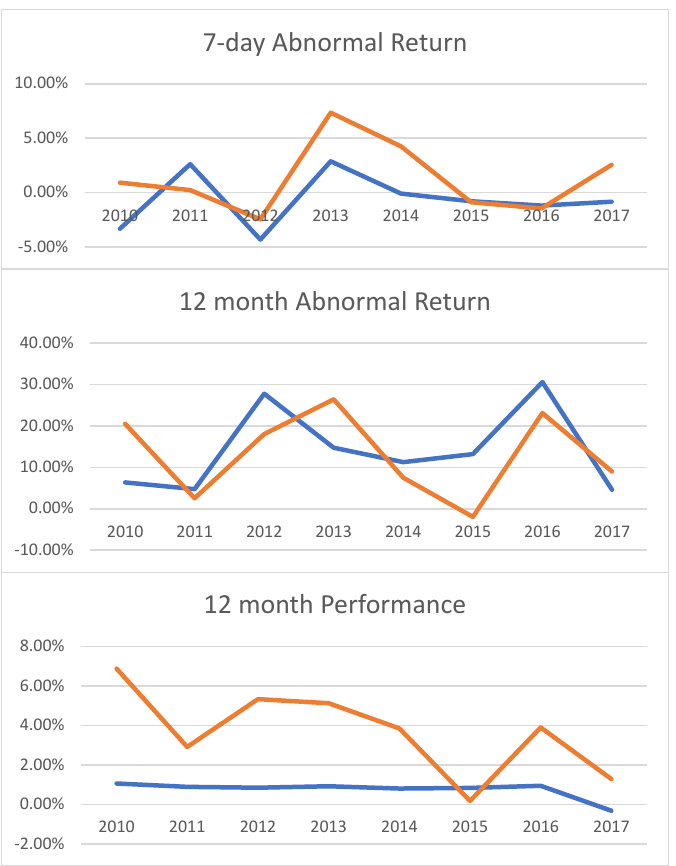
Figure 2. Time Series of Returns and Performance. The three panels of this figure compare the year-by-year announcement period abnormal acquirer stock returns from 3 days before the announcement to 3 days after (CAR_VW7), longer-run 12-month post-announcement abnormal returns (CAR_VW_12 Month), and performance defined as the return on assets (ROA) 12 Month post acquisi- tion (ROA_12 Month), between banks and non-banks. Plots in red are for non-banks, and those in blue are for